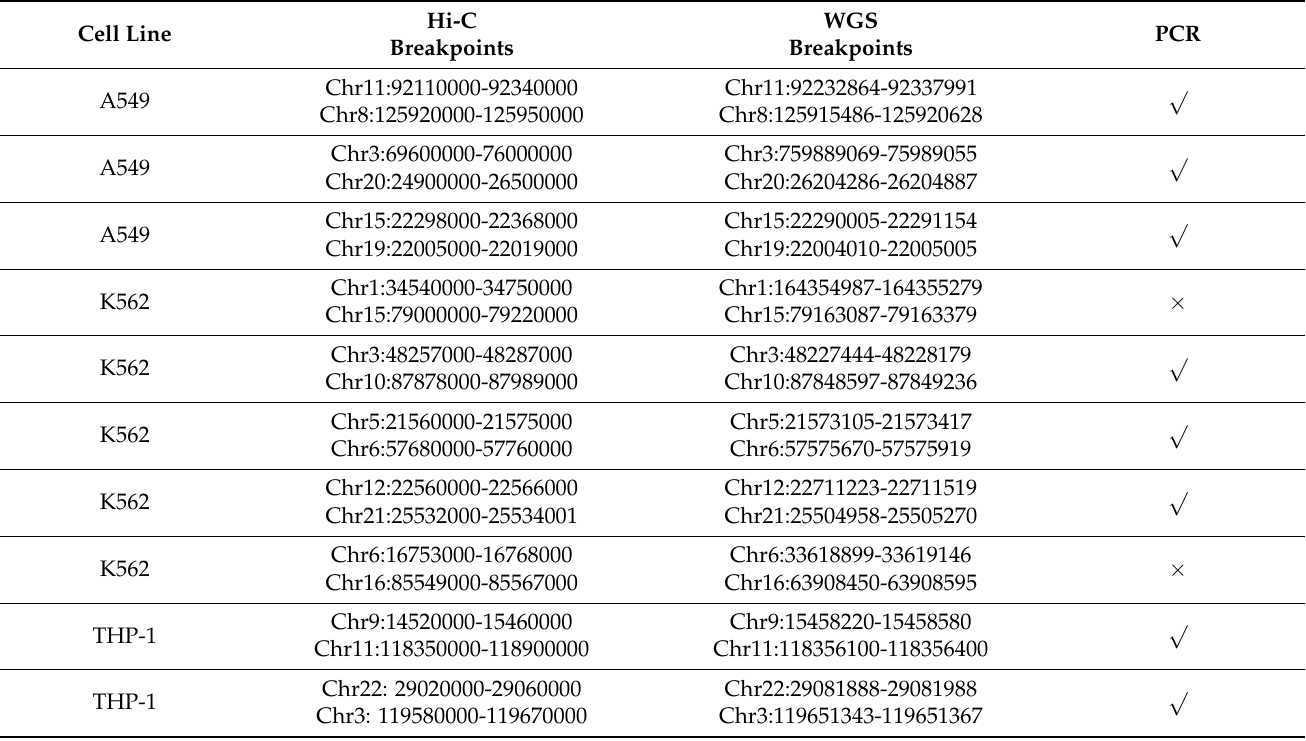
Table 2. Integrative summary of translocation breakpoints and cross-validation